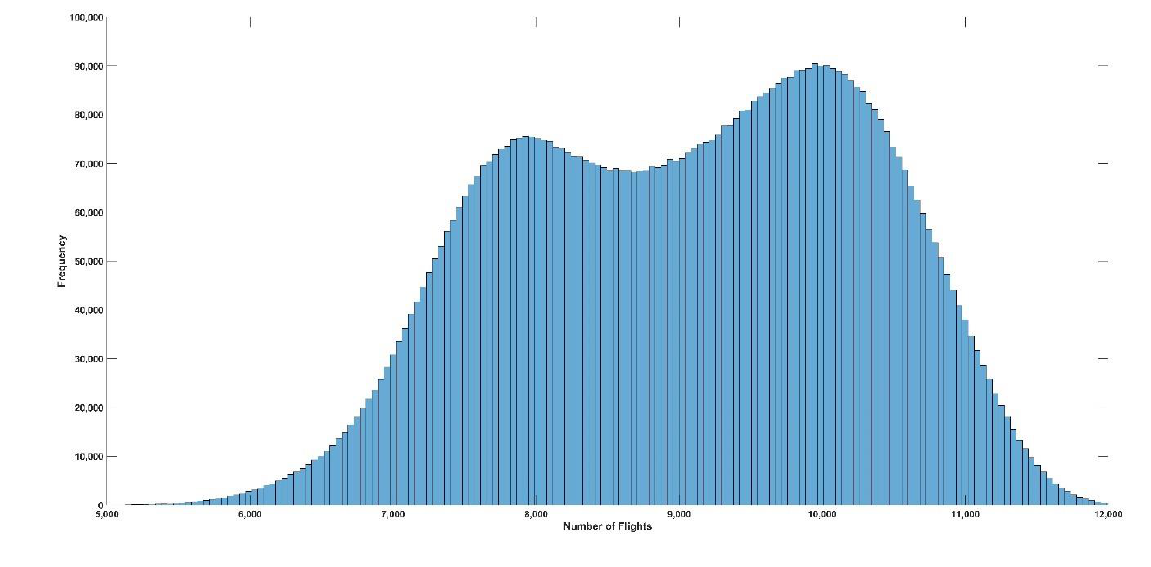
Figure 8. Distribution simulation flights traffic year 2019